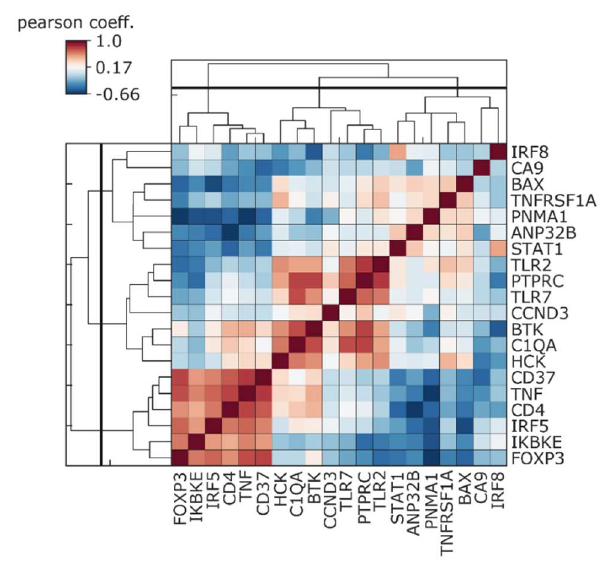
Figure 8. Negative correlation between CA9 and immune panel genes which are upregulated in samples with better prognosis. The analysis was performed with GSE19650 consisting of intraductal mucinous neoplasia and normal tissues. Immune gene panel indicates immune-related genes as predictors of outcome in pancreatic adenocarcinoma according to D’Angelo et al. [145].